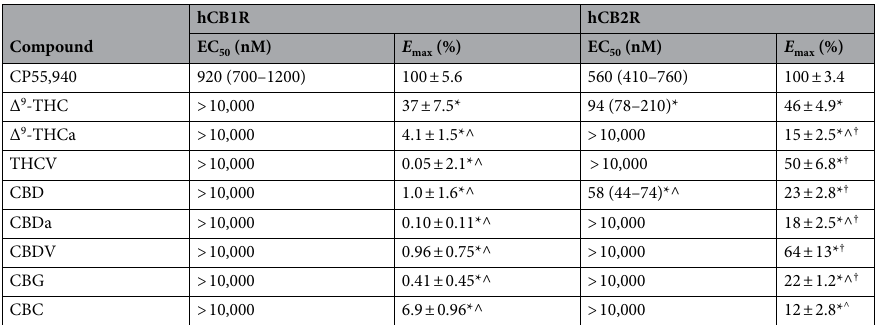
Table 3. hCB1R- or hCB2R-dependent recruitment of βarrestin2. hCB1R-or hCB2R-dependent recruitment of βarrestin2 was quantified in PathHunter CHO cells stably expressing hCB1R or hCB2R and treated with compounds for 90 min. Data were fit to a variable slope (4 parameter) non-linear regression in GraphPad (v. 8). n ≥ 6 independent experiments performed in triplicate. E Max refers to the top of the concentration–response curve. Data are expressed as nM with 95% CI or %CP55,940 response, mean ± SEM. *p < 0.05 compared to CP55,940; ^p < 0.05 compared to ∆ 9 -THC within assay and measurement; †p < 0.05 compared to hCB1R within compound; as determined via non-overlapping 95% CI or one-way ANOVA followed by Tukey’s post- hoc test. Corresponding graphs are presented in Figs. 4 and 7.